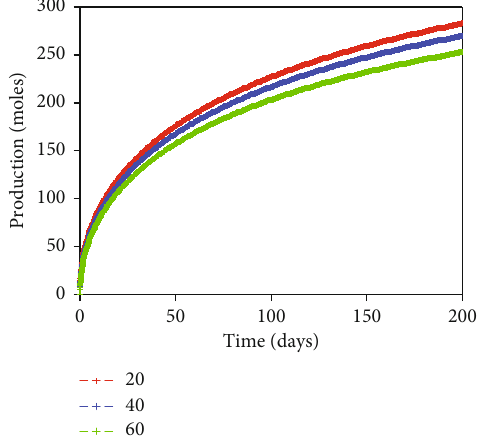
= 60 mol/m 3 at di ff erent times. b